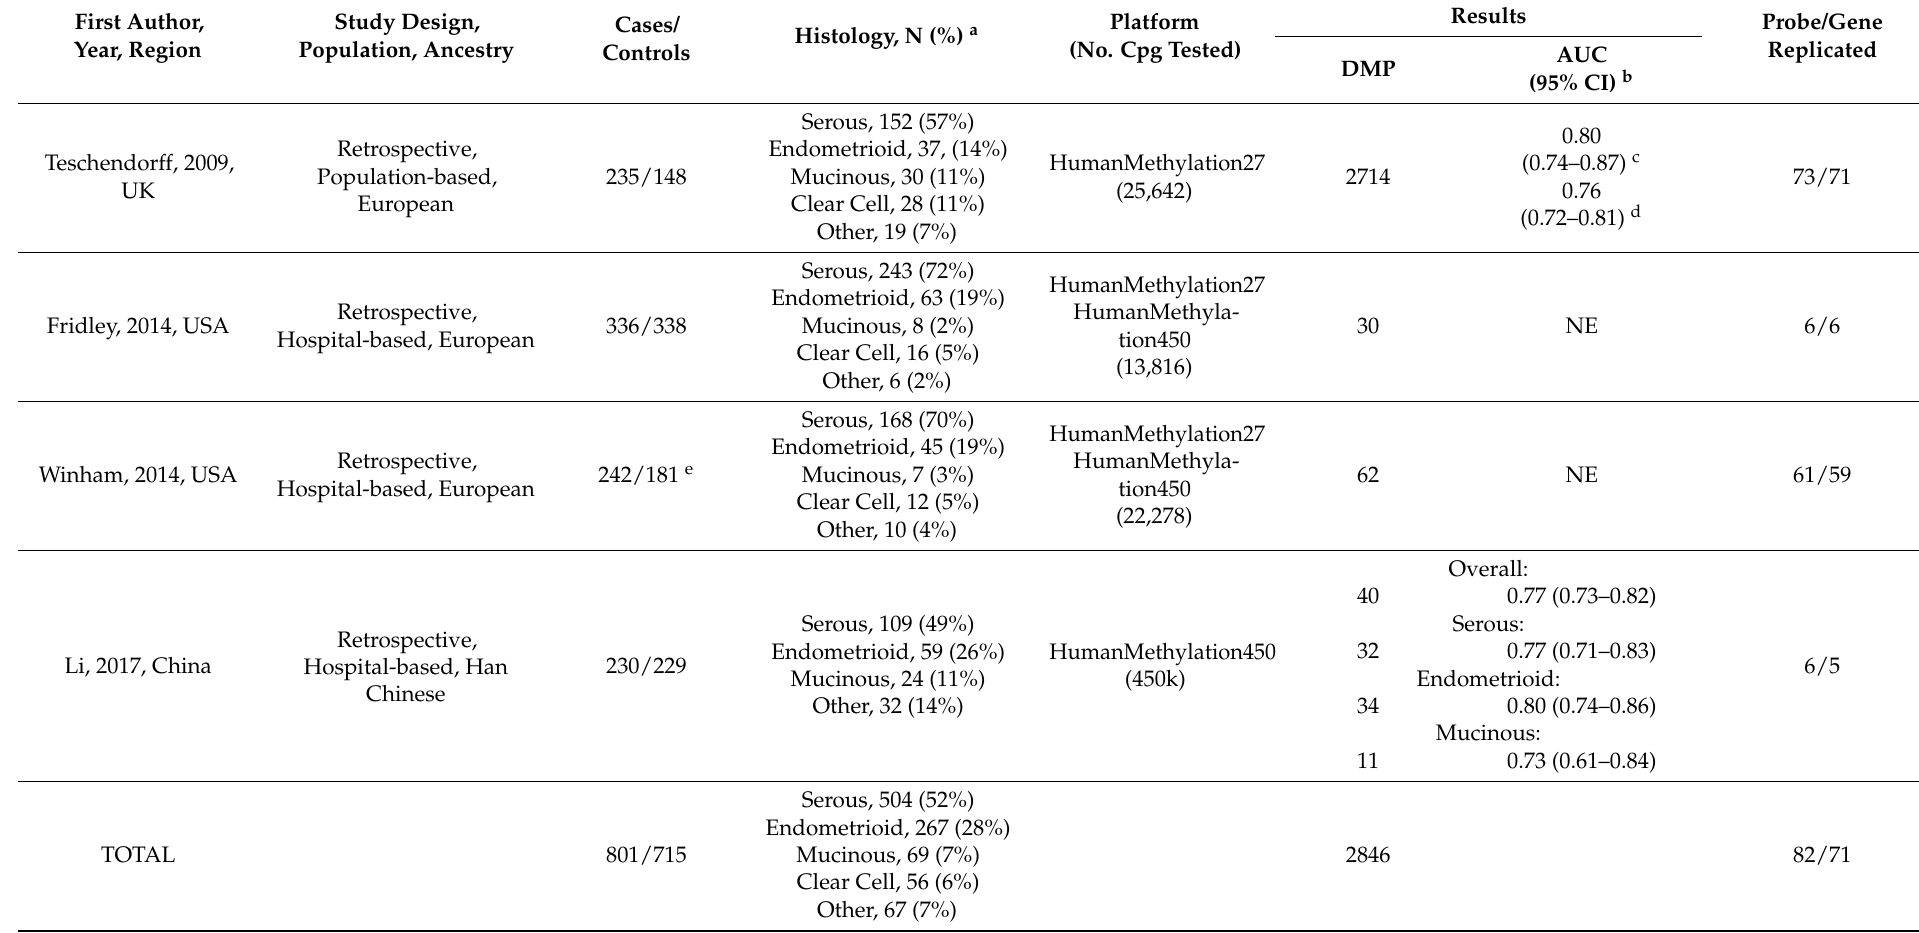
Table 2. Epigenome-wide association studies of DNA methylation in ovarian